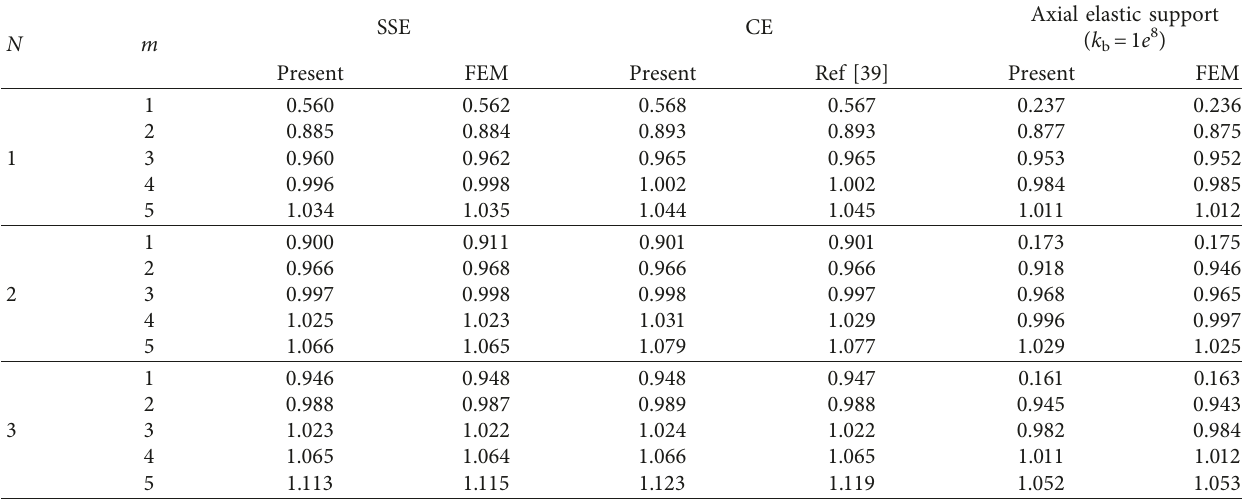
Table 3: Comparison of frequency parameters Ω of uniform hemispherical cap subjected to different edge conditions.